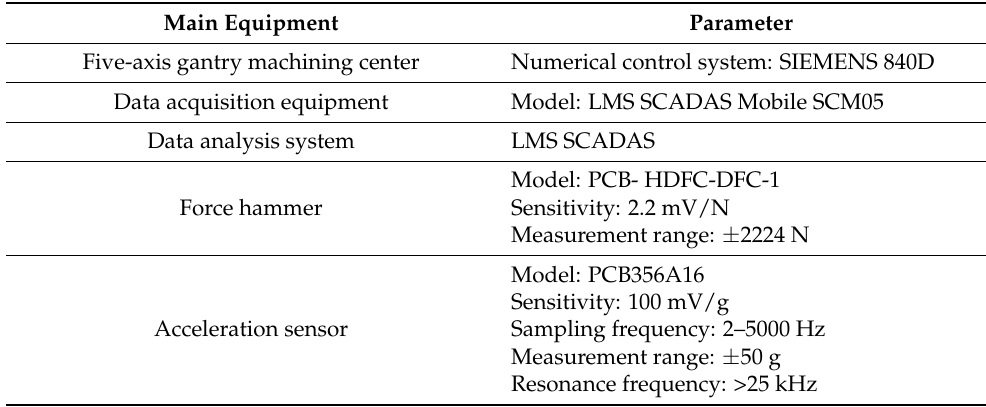
Table 1. Main equipment for EMA.